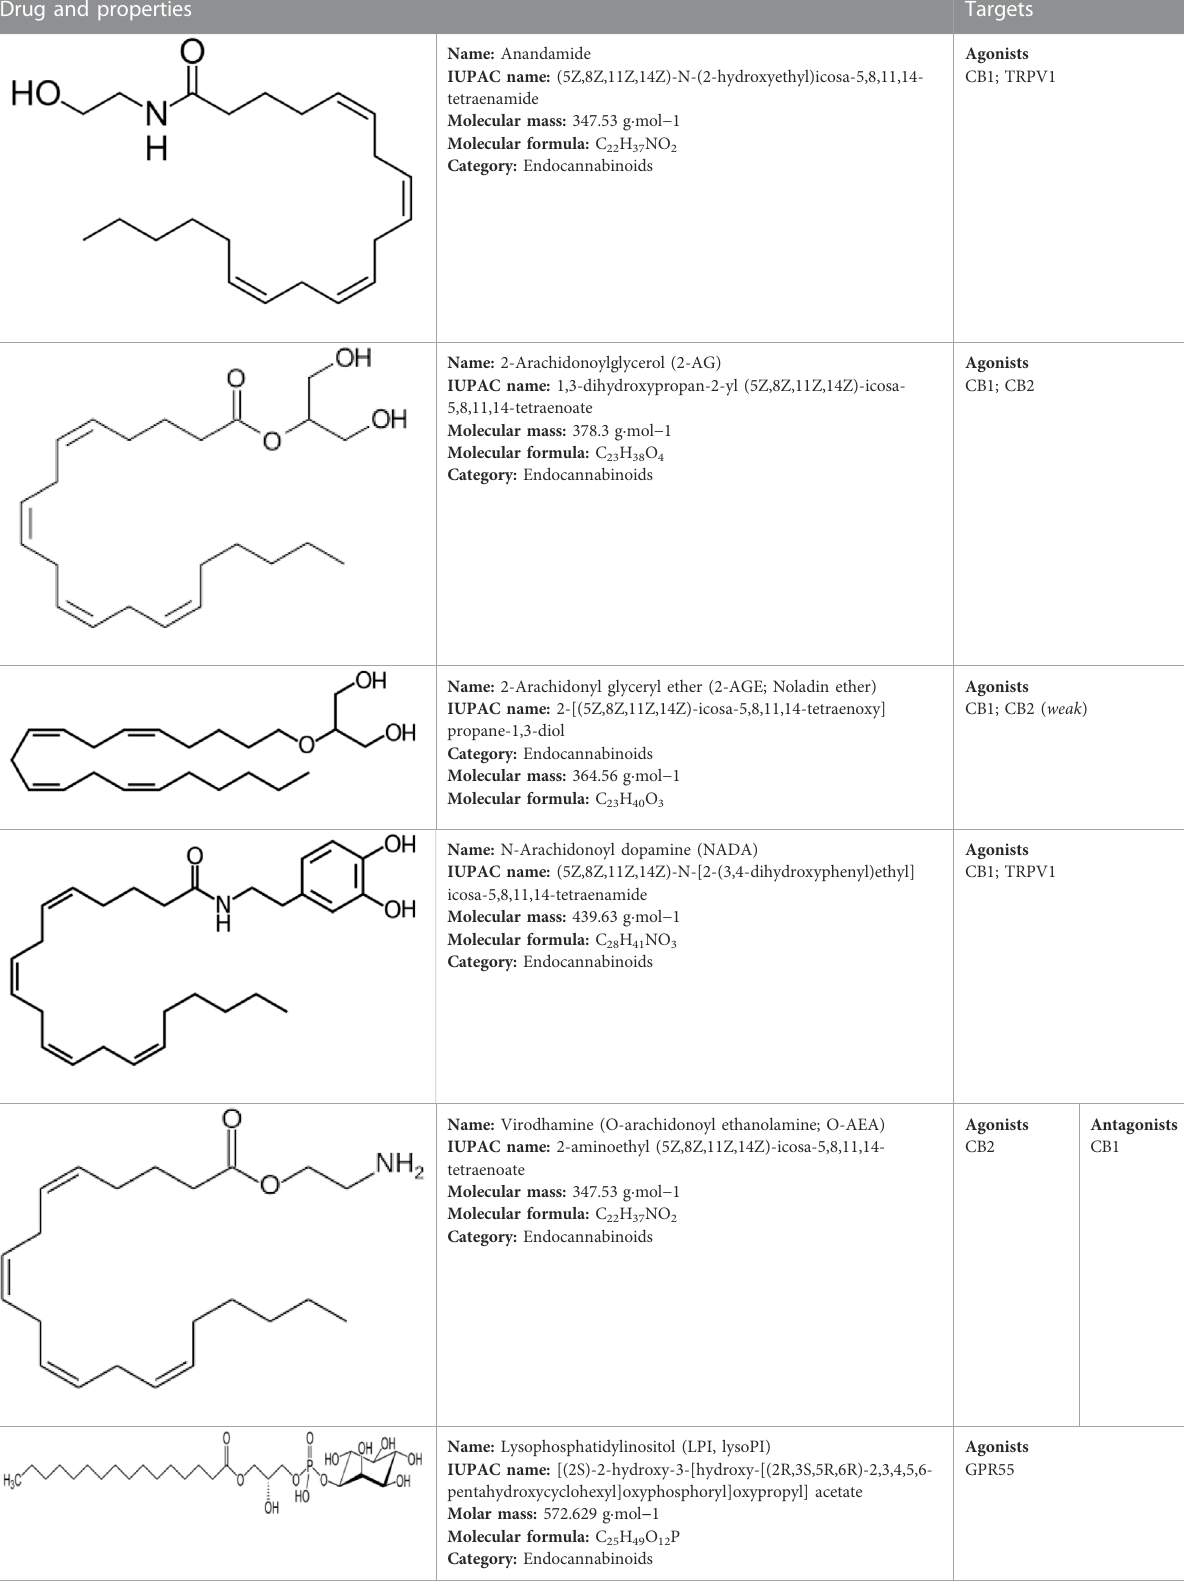
TABLE 1 Pro fi le of the different cannabinoids and drugs that act on the cannabinoid system that may be effective in the treatment of audiovestibular disorders. Drug and